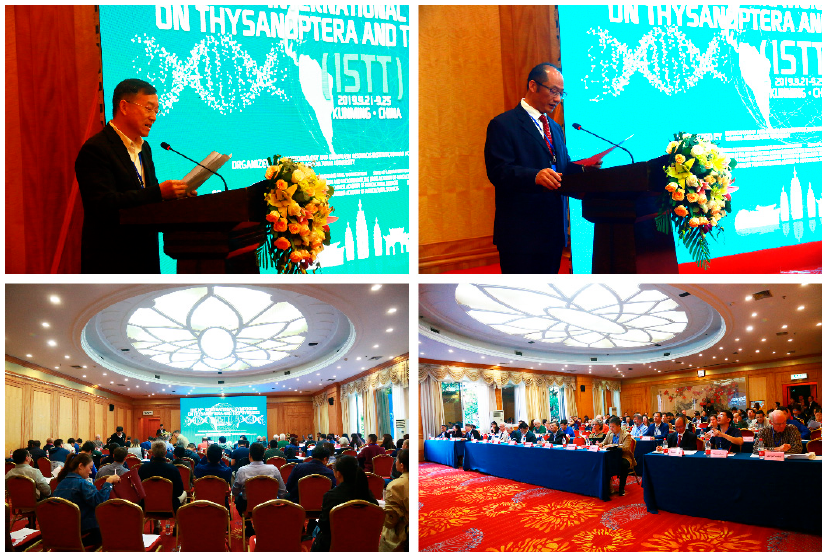
Figure 1. Opening ceremony of The XIth International Symposium on Thysanoptera and Tospoviruses in Kunming, China 2019.